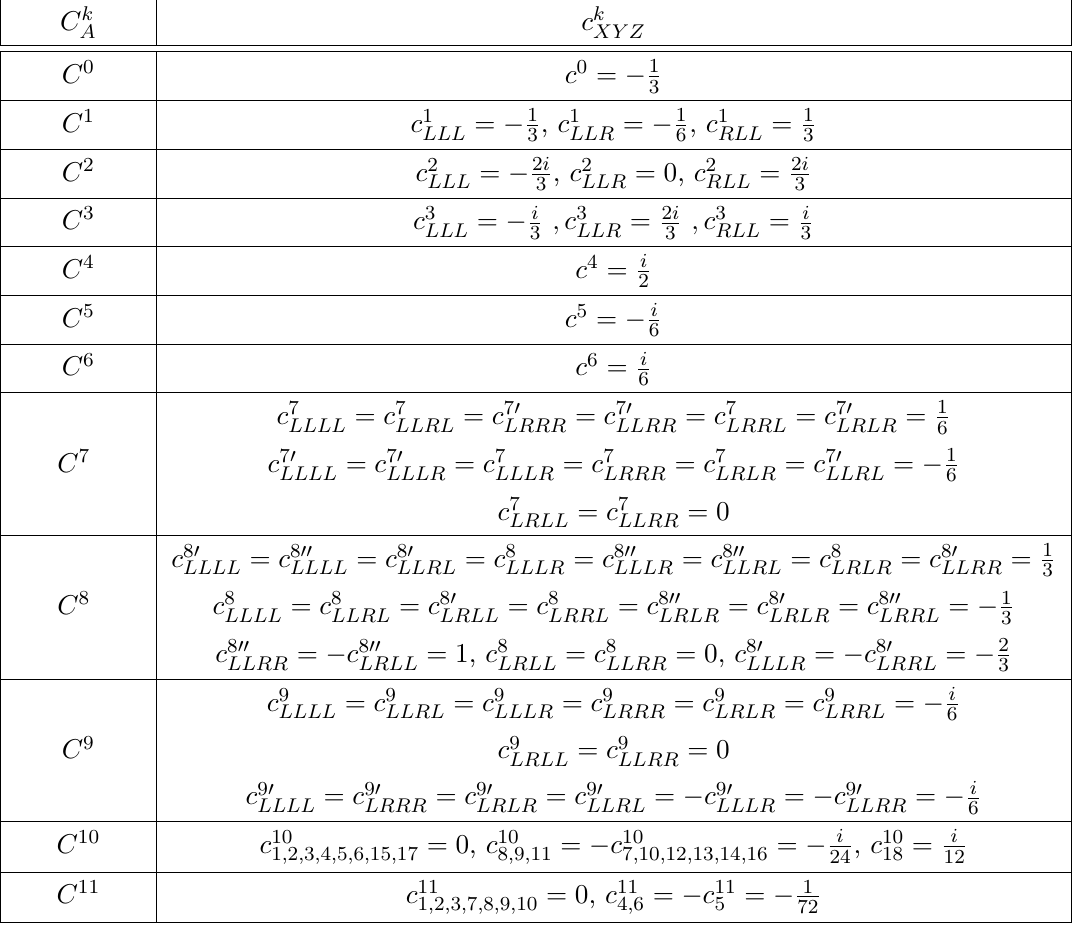
parametrization A